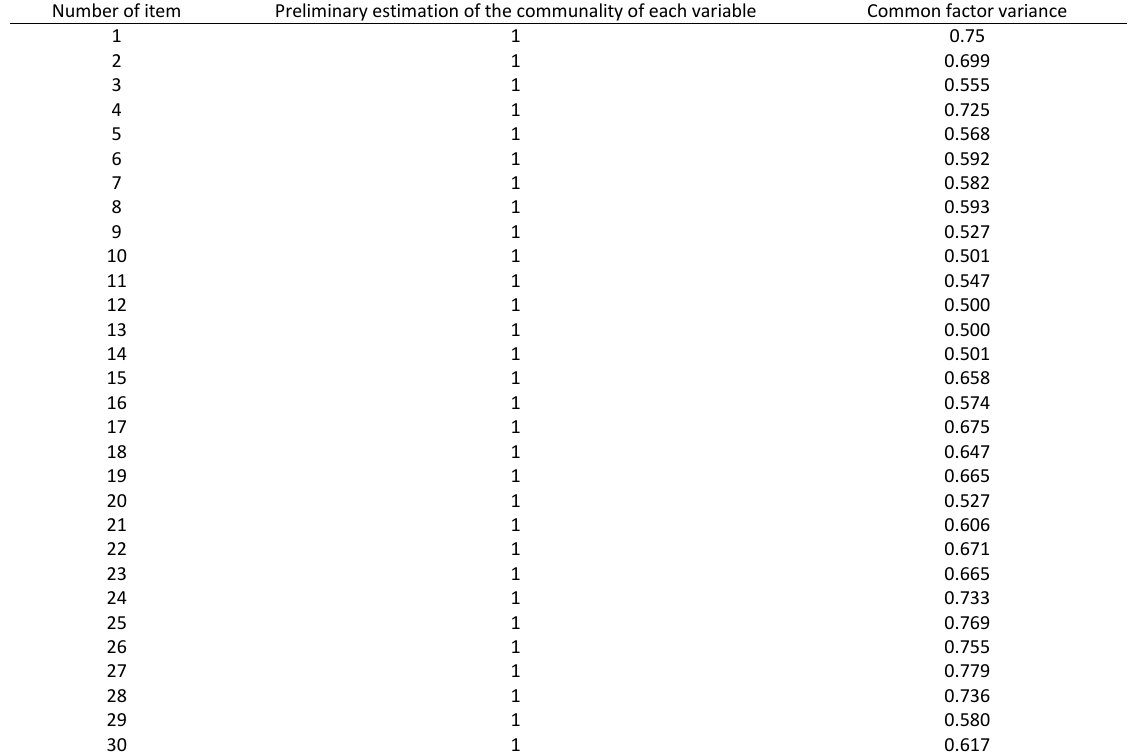
Table 1: The factor load matrix of each items of the questionnaire Number of item